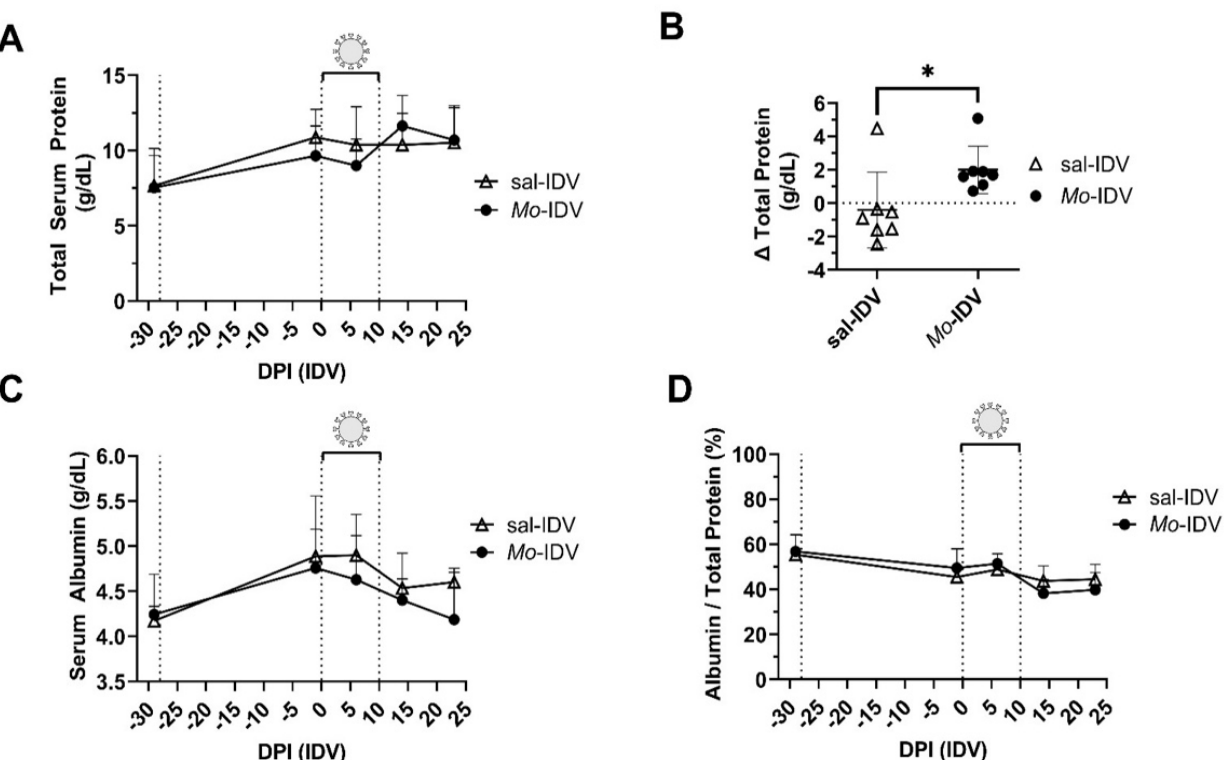
Figure 3. Prior infection with M. ovipneumoniae has a minimal effect on IDV-associated acute-phase response. ( A ) Total serum protein was measured throughout duration of study. ( B ) Change in total serum protein between 1 day prior to IDV infection and 14 days post-infection. ( C ) Serum albumin concentration were measured throughout duration of study. ( D ) Ratio of serum albumin:total protein. Vertical dotted lines signify inoculation with M. ovipneumoniae or IDV, or the last observed timepoint of IDV shedding, respectively. DPI: days post-infection. Data are presented as mean ± SD. Comparisons were evaluated by Student’s t -test. * Bonferroni–Dunn adjusted p < 0.05. While it has been used as a prognostic indicator in some species, the predictive power of L-lactate in sheep infection outcomes remains unexplored in a controlled infection